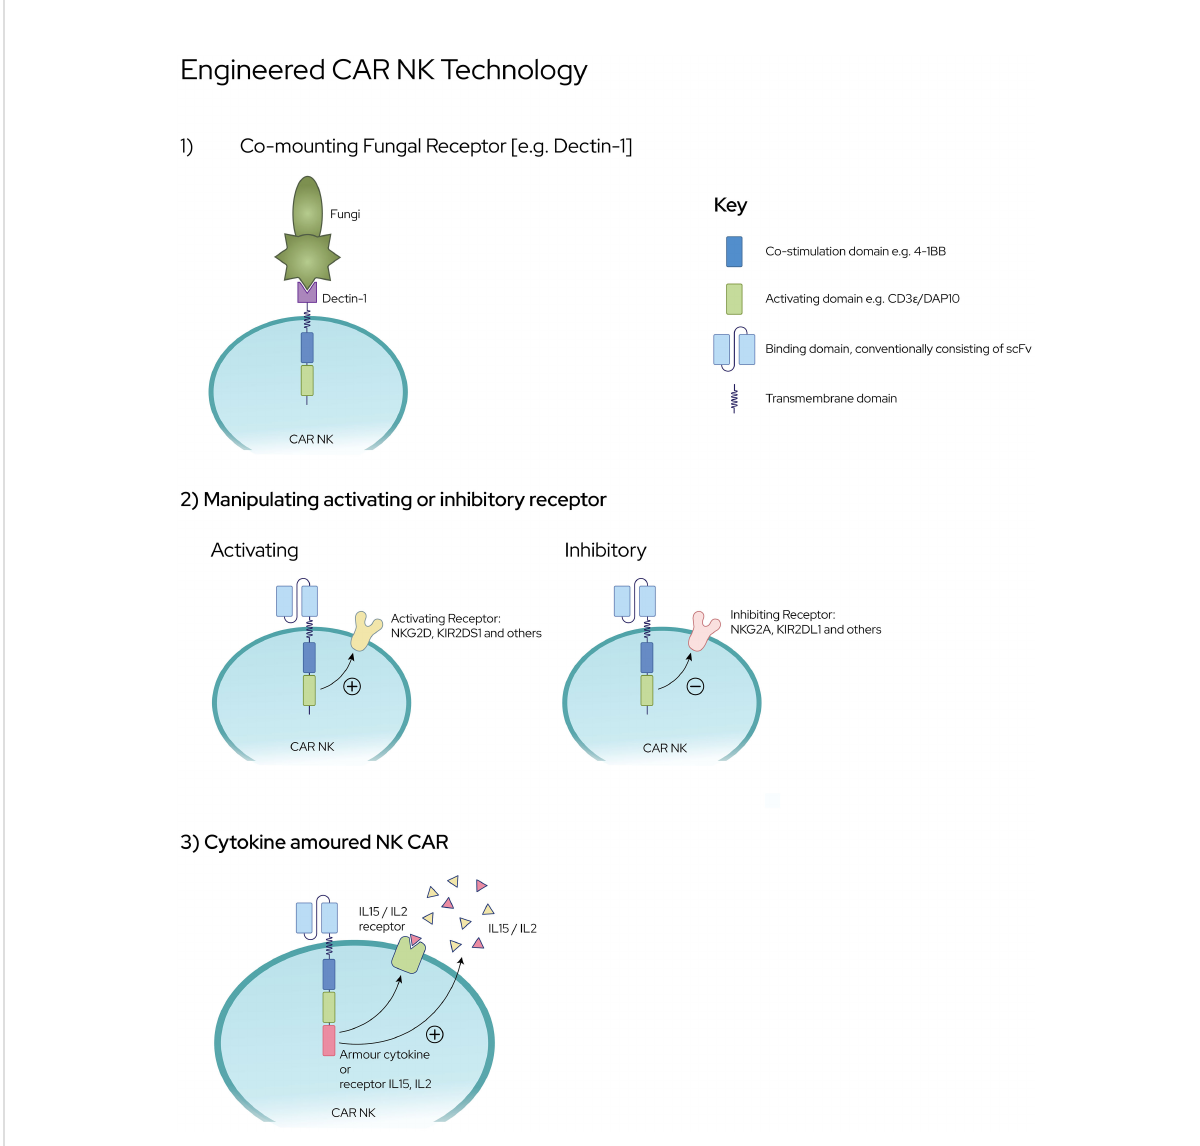
FIGURE 2 Engineering CAR NK Platforms against Invasive Fungal Infections [1] CAR NK cells co-expressing fungal speci fi c receptors e.g., Dectin-1 fused to co-stimulation and activating domains [2] Enhanced expression of NK-activating receptors or down regulation of NK-inhibitory receptors upon ligation [3] NK cells with ‘ cytokine-armouring ’ capability for superior persistence and sustenance against fungal